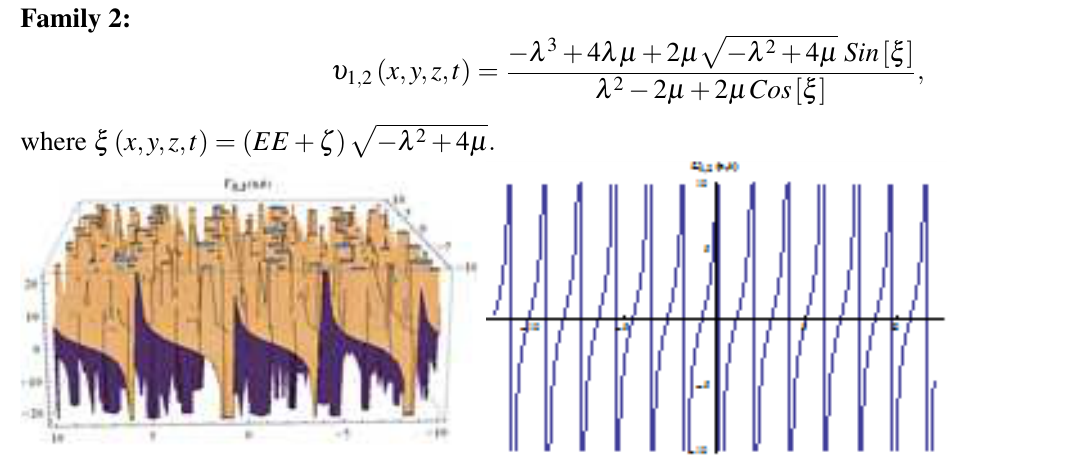
Figure 2. The 3D and t = 1 for 2D of Eq.(18)